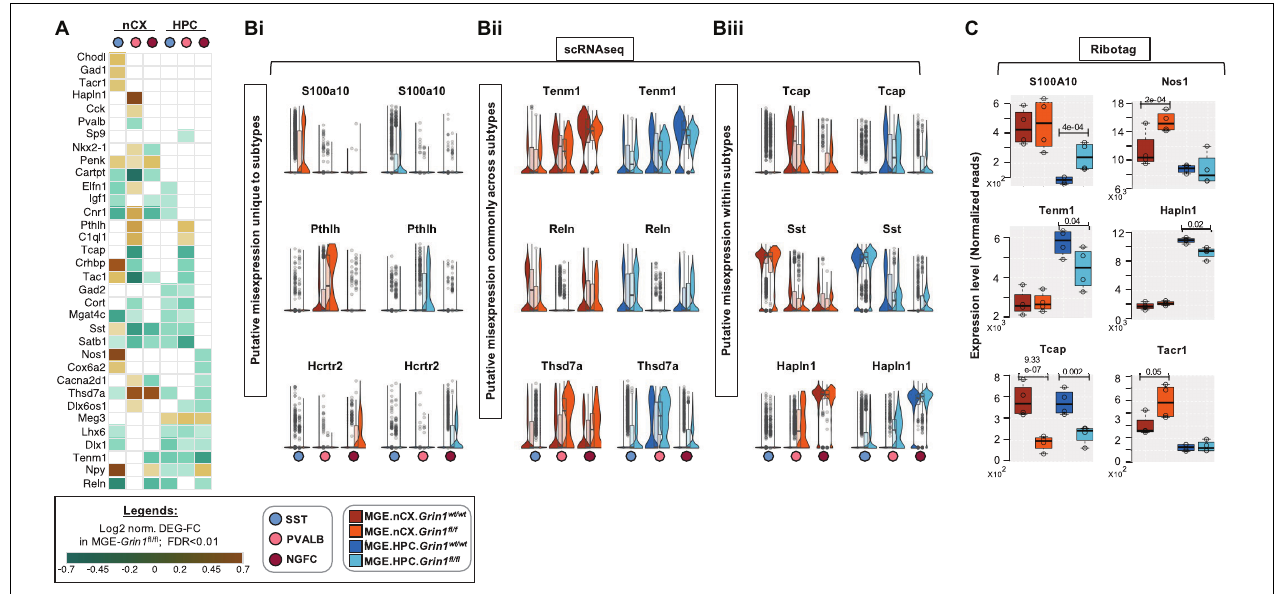
FIGURE 7 | Differential expression of interneuron marker genes across subtypes upon Grin1 -ablation. (A) Heatmap of log2 FC of significant DEGs in neocortical and hippocampal MGE cardinal subtypes, showing notable MGE marker genes. Representative box-violin plots of top differentially expressed genes from the above that represent (Bi) , a misexpression unique to a single MGE-interneuron subtype in the Grin1 fl / fl (Bii) , a misexpression across all MGE-derived interneuron subtypes in the Grin1 fl / fl ; (Biii) , a misexpression between MGE-derived interneuron subtypes in the Grin1 fl / fl . (C) MGE-Ribotag-seq normalized reads, cross-validating the misexpressed interneuron marker genes in neocortex and